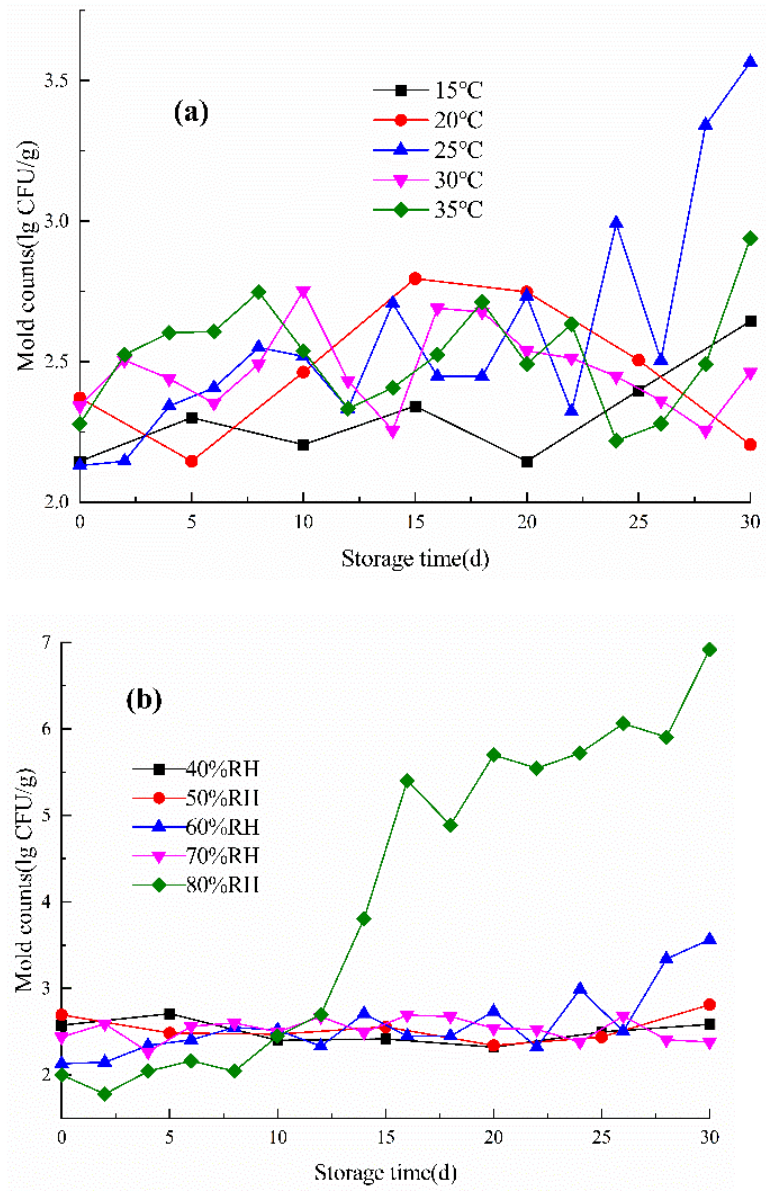
Figure 4. The trend for the mold count of fishmeal: ( a ) at 15 ◦ C, 20 ◦ C, and 25 ◦ C, 30 ◦ C, and 35 ◦ C; ( b ) at 40% RH, 50% RH, 60% RH, 70% RH, and 80% RH.